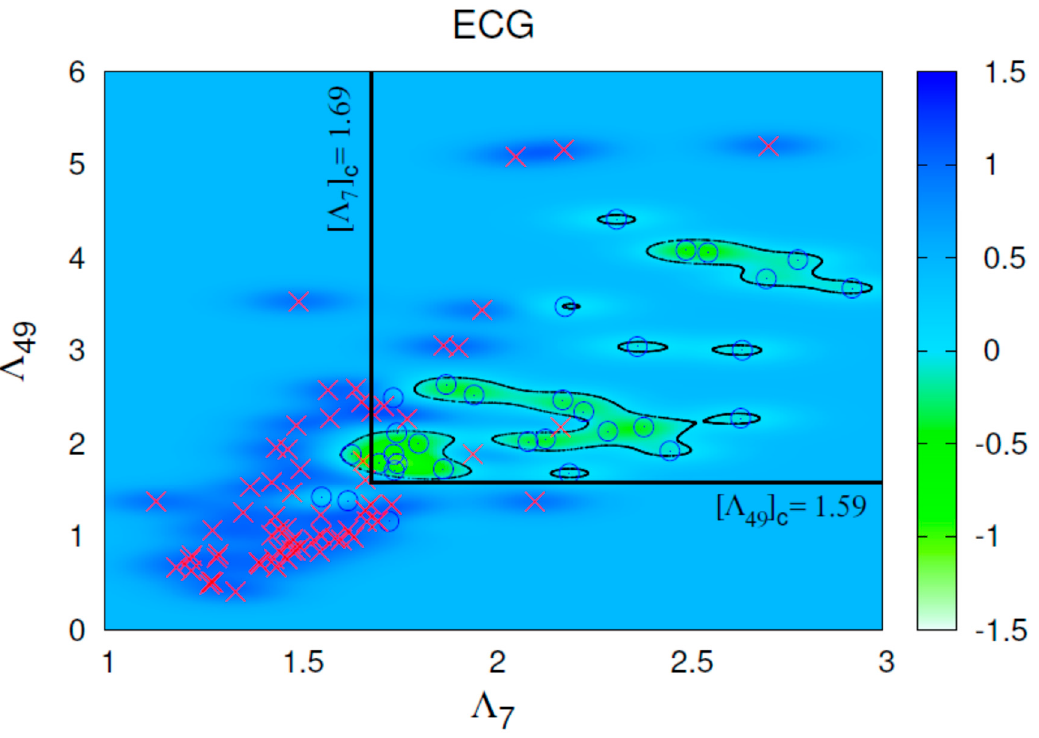
Figure 10. Results comprising 32 Healthy (blue circles) and 67 CHF (red crosses) individuals. The color contours correspond to the argument of the signum in the decision function of Equation (12) obtained by SVM with radial basis kernel function with γ = 60. The black dotted points correspond to the decision boundary and enclose the H region found by SVM.